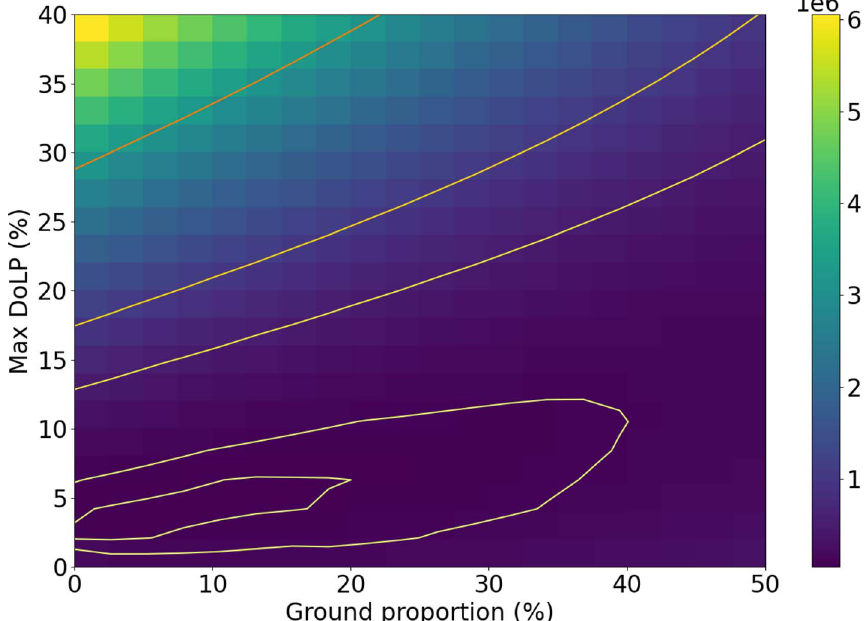
Fig. B.1. Normalized square differences between the observations (2020 green line, see Fig. 8) and the model as a function of the ground proportion and the d max parameter. The azimuth is fi xed at 50 (cid:3) and the elevation at (cid:3) 20 (cid:3) . The contour shows the lines of constant cost at 0.05, 0.1, 0.5, 1, and 3 (cid:2) 10 6